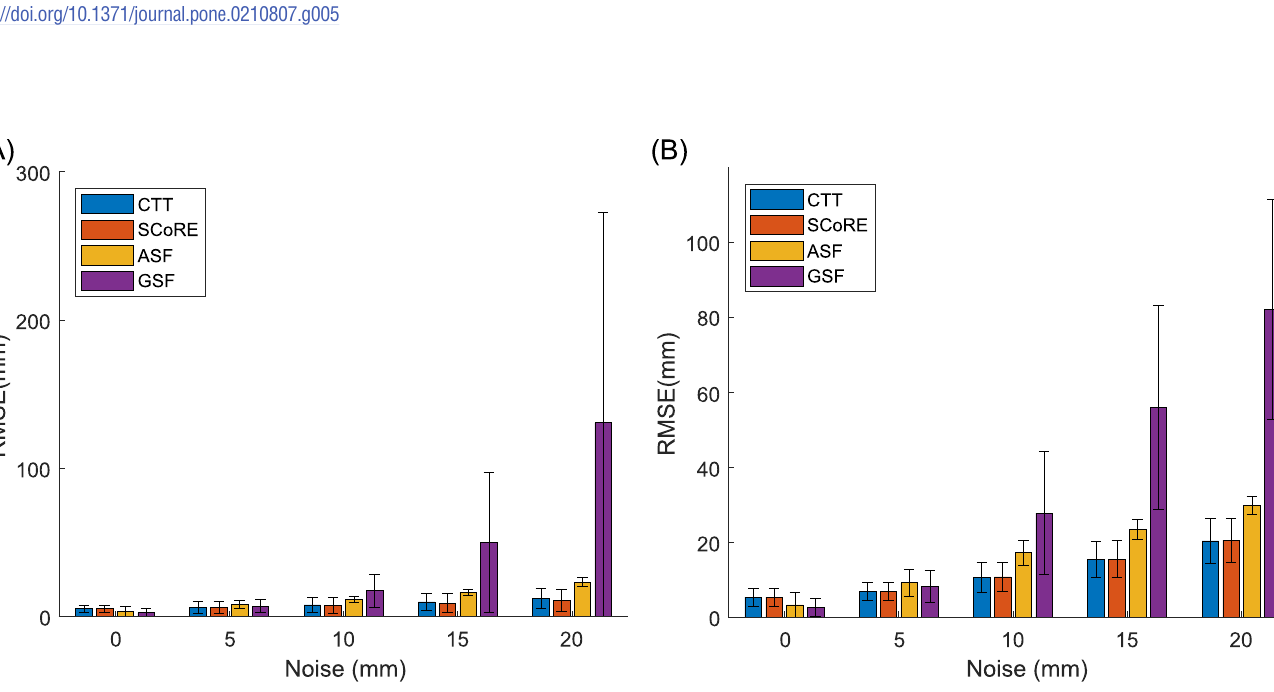
Fig 6. CoR estimate errors (RMSE) when varied amplitudes of random Gaussian noise. The random Gaussian noise was applied to the proximal (A) and distal (B) markers respectively. The mean changes associated with the CTT and SCoRE algorithms are smaller than the mean changes from the sphere fitting methods. Each error bar represents one standard deviation. The data is relative to “fast and normal” motion